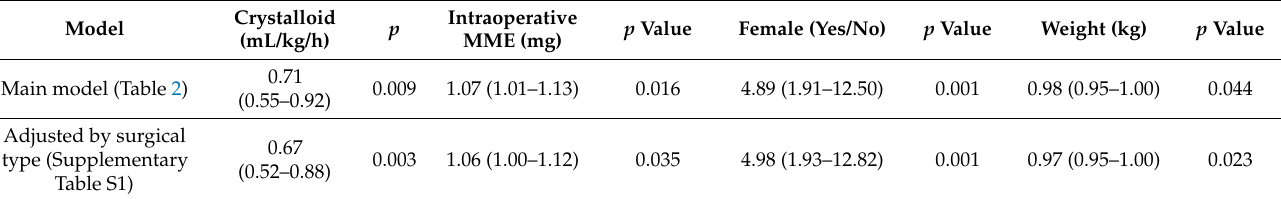
Table 3. Multiple logistic regression model of postoperative vomiting adjusted by surgical